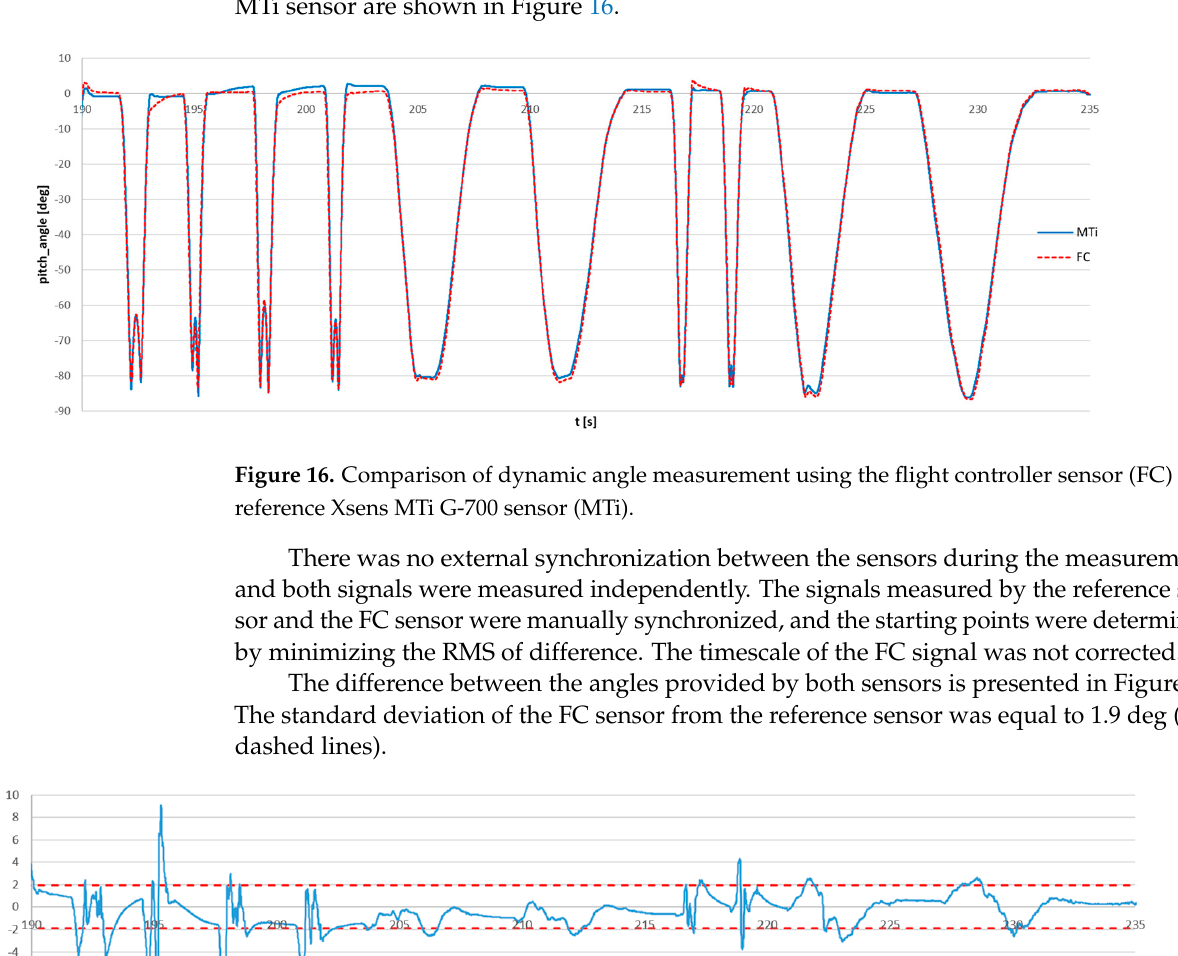
Figure 15. Measurement of impulse excitation by five flight controller sensors (FC1–FC5) after the synchronization and reference signal measured with the Xsens MTi-G700 sensor (MTi). Magnifica- tion of the initial ( a ), middle ( b ), and last pulse ( c ). ∆ t: shift between the reference pulse and the FC pulse.